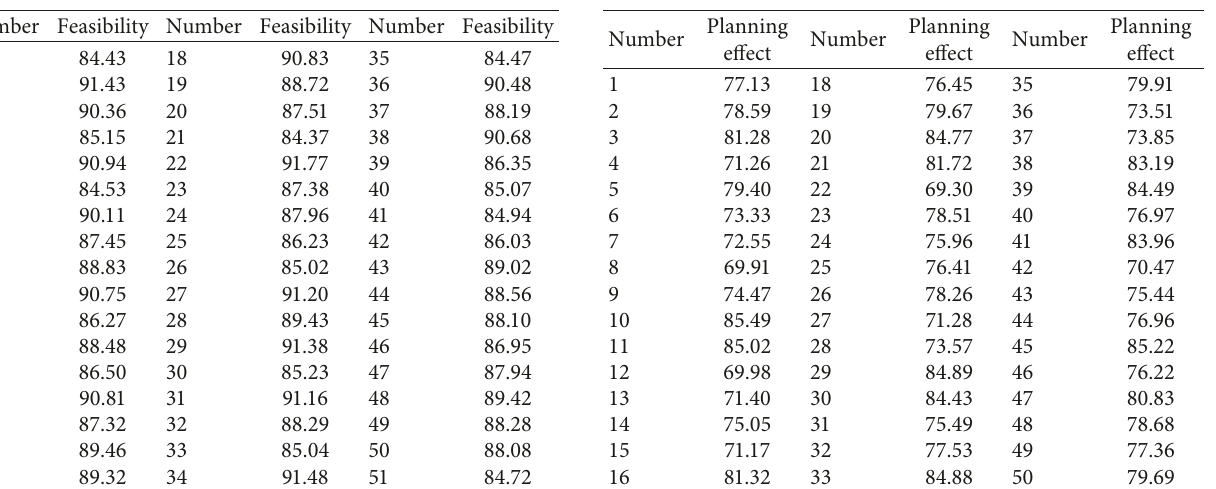
Table 1: Feasibility analysis of design methods of smart public urban planning under public acceptability constraints.